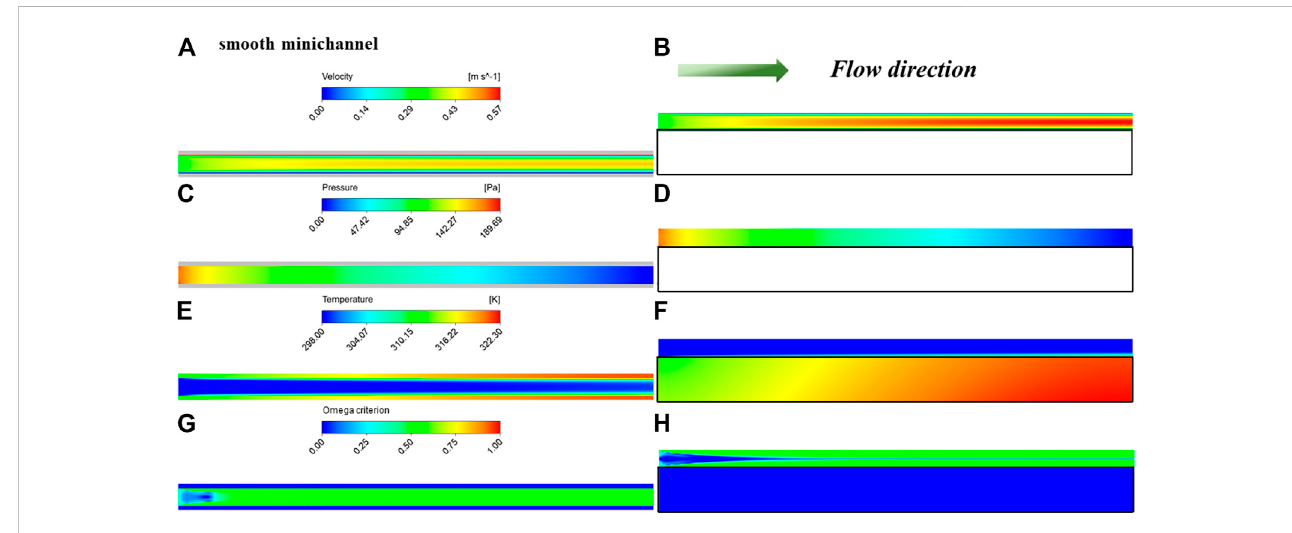
FIGURE 7 Contours of velocity, pressure, temperatureand omega criterion values attheplanes for thesmooth minichannel: (A, C,E, G) for theplane(z=5.5 mm); (B, D, F, H) for the plane (y = 1.5 mm).